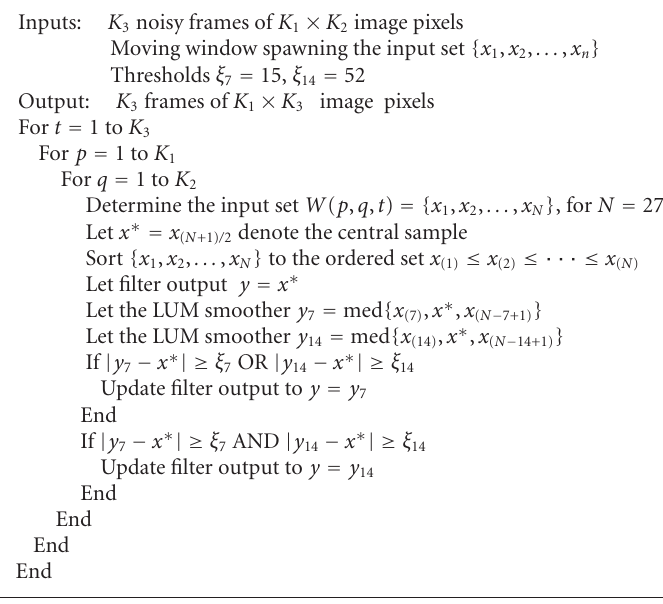
Algorithm 1: Algorithm of the reduced NAVF